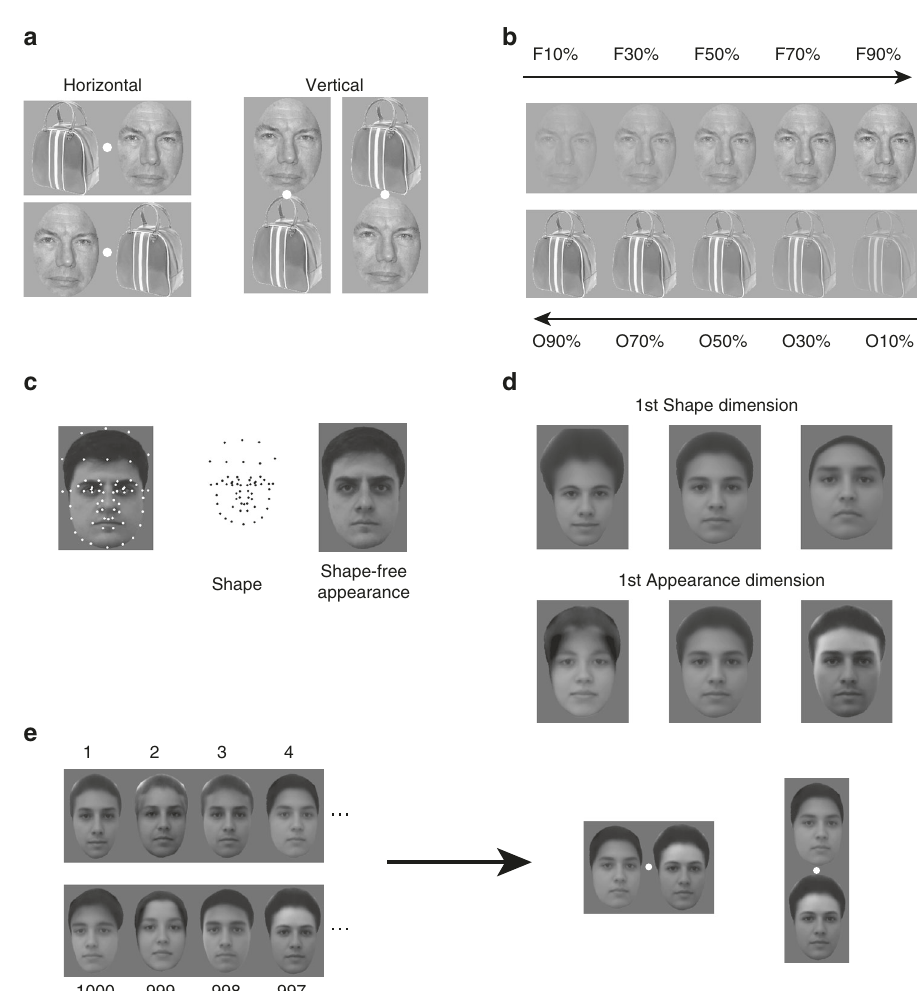
Fig. 1 Stimuli for the experiments. a Two spatial con fi gurations were used in the face-object experiments: horizontal (left) and vertical (right). b For each con fi guration and each face-object pair, fi ve different relative contrast levels were tested. c 58 landmark points were labeled on 200 facial images from a face database (FEI face database; example image shown on left). The positions of these landmarks carry shape information about each facial image (middle). The landmarks were smoothly morphed to match the average positions of the 200 faces, generating an image carrying normalized appearance information about each face (right). d Facial images corresponding to the fi rst PC for shape (top) and the fi rst PC for normalized appearance (bottom). e 1000 images were randomly drawn from this space and then paired; four pairs are shown (left). Face pairs were presented in two spatial con fi gurations, horizontal and vertical (right). The face image Fig. 1a, b is from the FERET face database 51,52,] . The bowling bag image in a and b is similar to the one actually shown, but due to copyright reasons, we cannot show the original. The faces in d , e were created by the computer program described in the